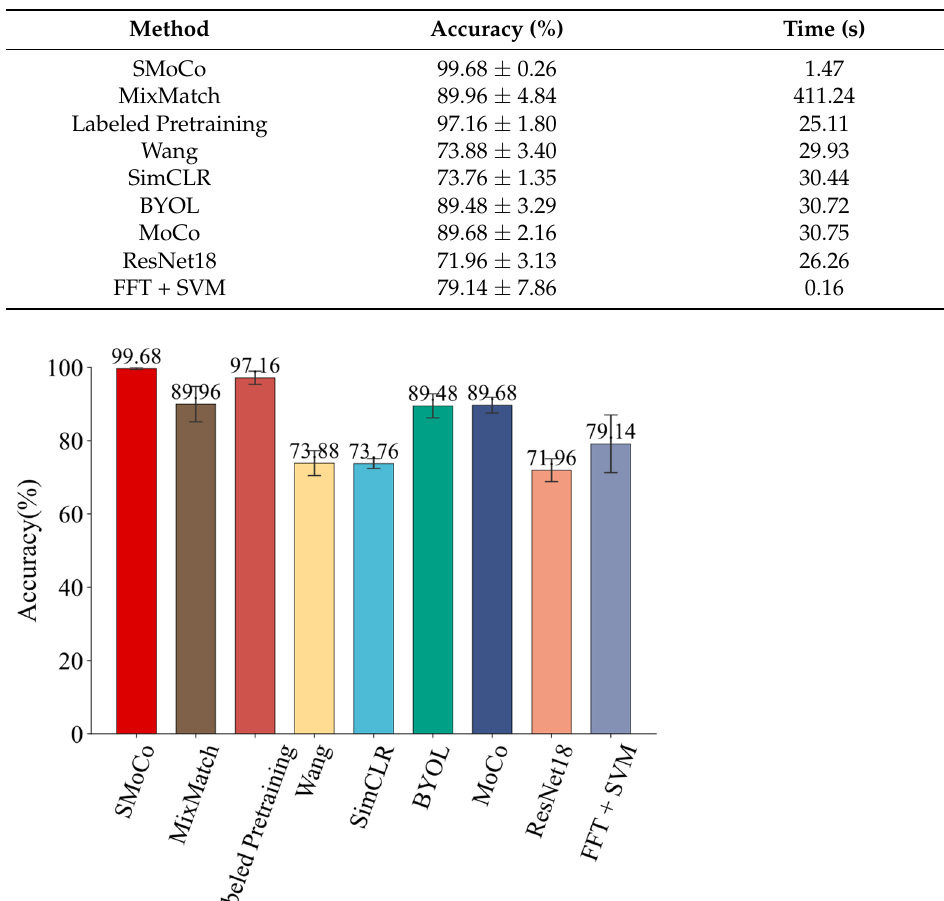
Table 5. Comparison of diagnostic results on dataset 2 under 5 samples per class.